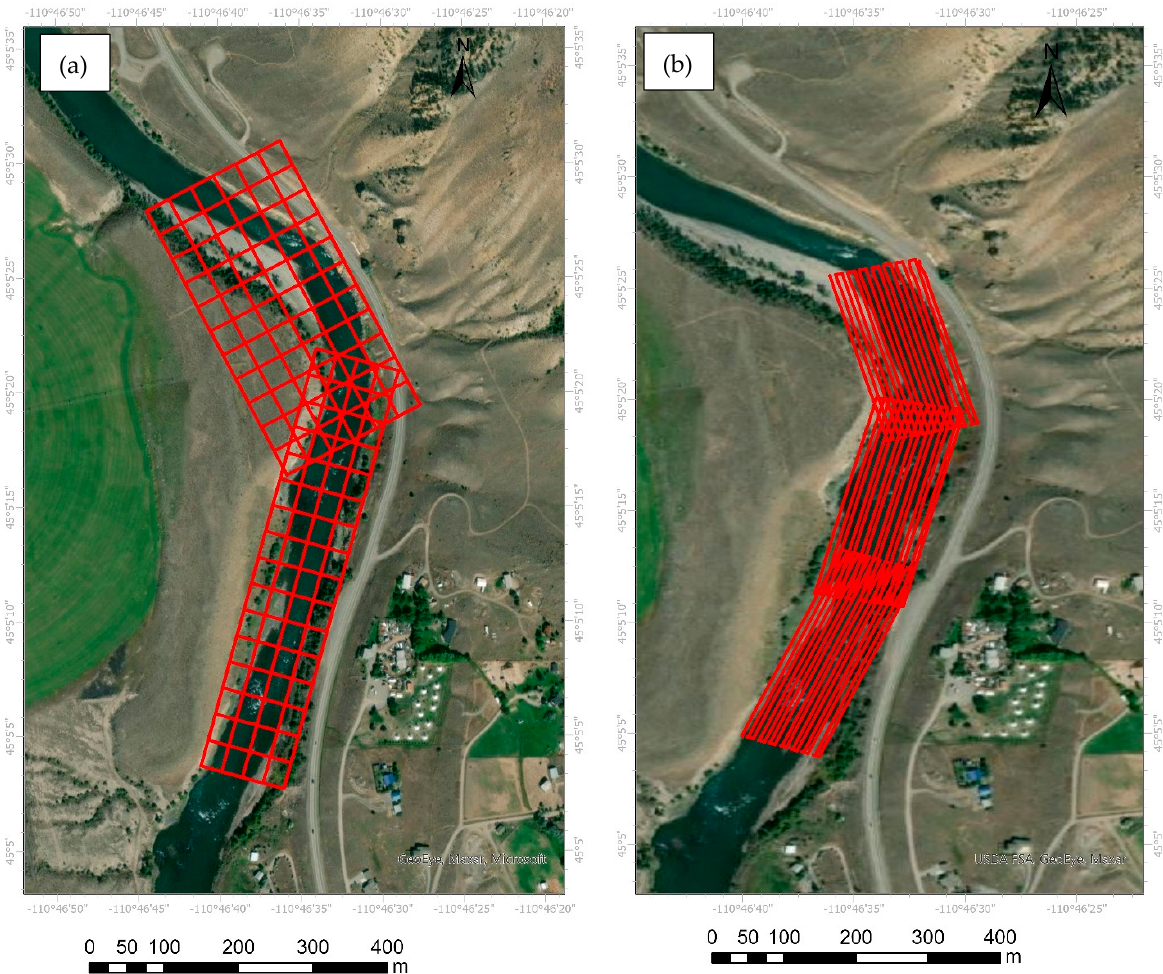
Figure 3. Flight paths generated in Pix4D Capture to conduct repeated surveys. Left figure ( a ) shows the two flight paths used to acquire RGB-imagery; the right figure ( b ) shows the three flight paths used to acquire thermal infrared (TIR) imagery. Credits for the background service layer: United States Department of Agriculture Farm Service Agency (USDA FSA), GeoEye Inc. and Maxar.